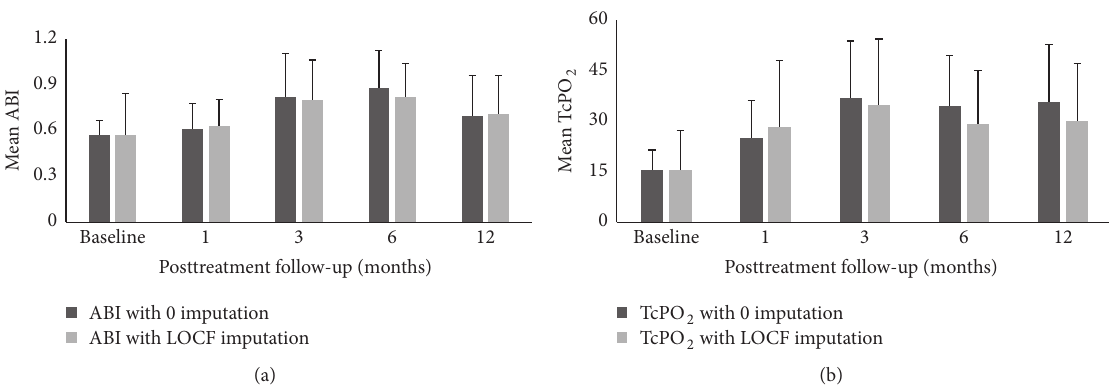
Figure 3: (a) Analysis of change in ABI using two imputation methods: “0” imputation and LOCF. (b) Analysis of change in TcPO 2 using two imputation methods: “0” imputation and LOCF.